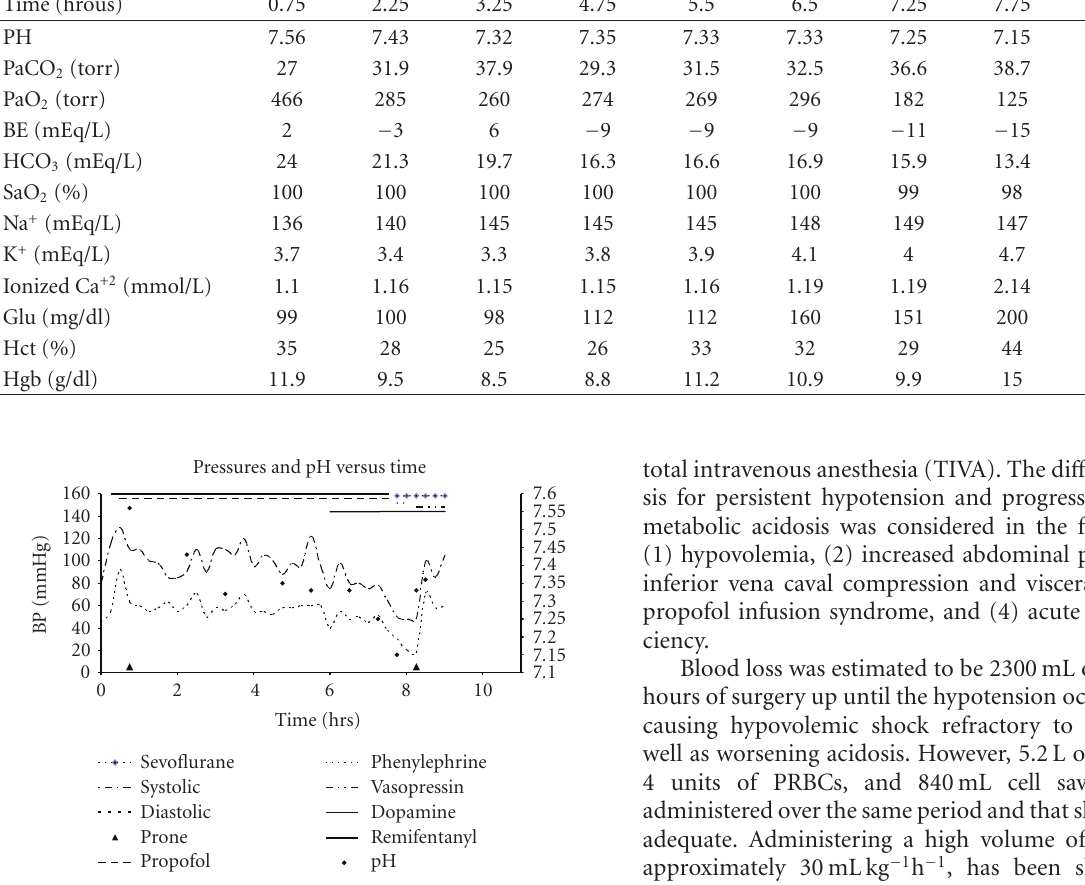
Figure 1: Vital signs and medications during surgery.